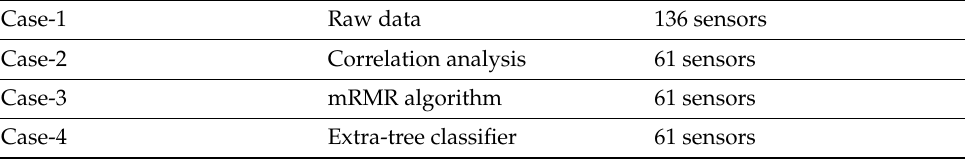
Table 6. Case scenarios for the machine-learning classification.